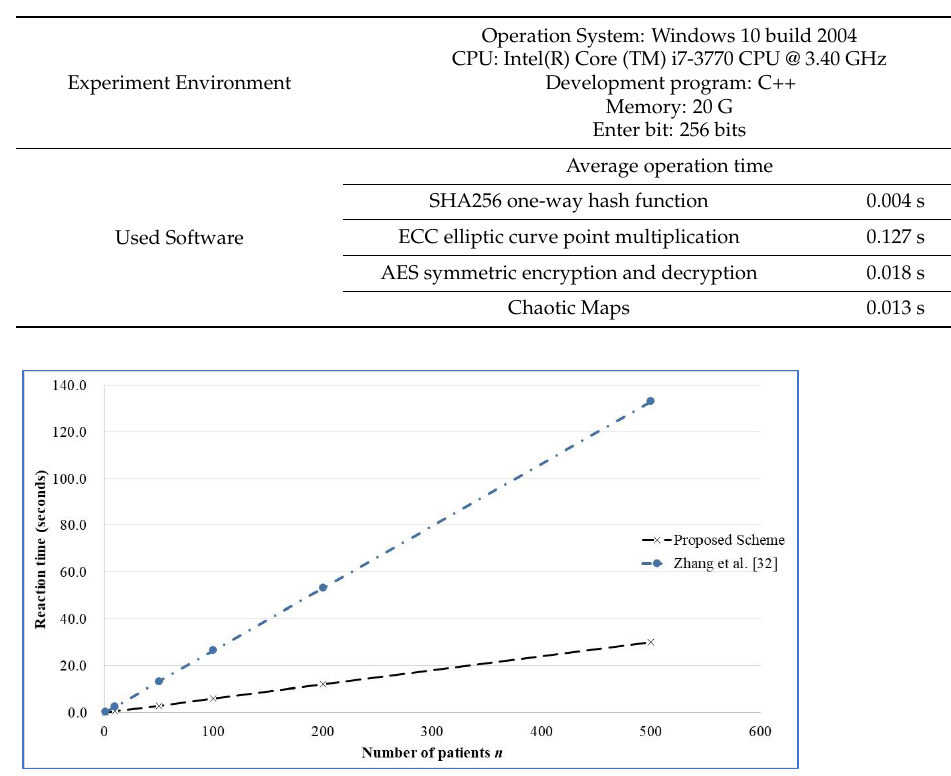
Table 4. Real machine efficiency simulation time.